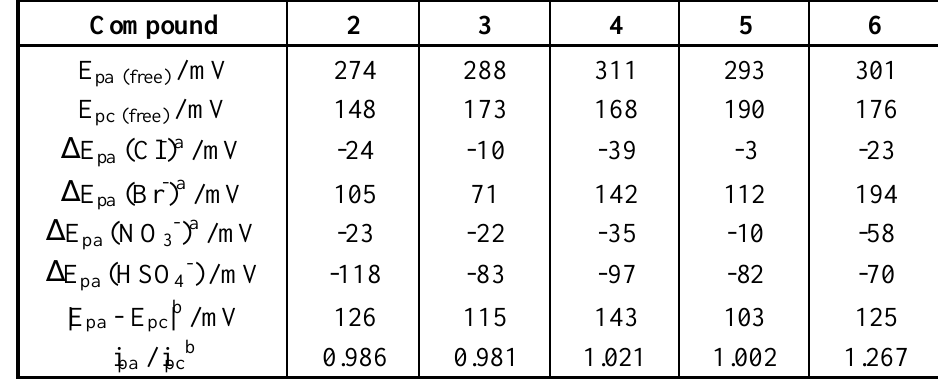
Table 1 : Electrochemical data for receptors 2 - 6